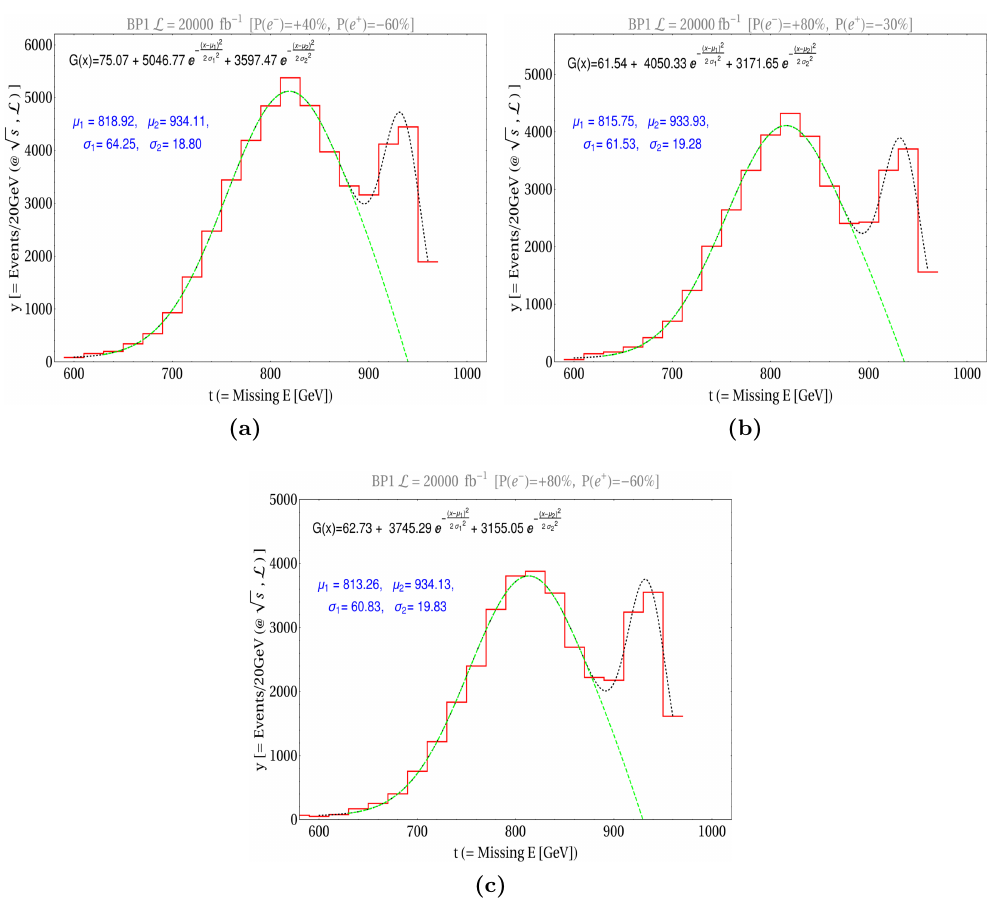
Figure 35. /E distribution for BP1 together with SM background and Gaussian fit for different beam polarizations: (a) P 1 0 ≡ { P : +0 . 4 , P : − 0 . 6 } ; ( b ) P 3 ≡ { P e + e − : +0 . 8 , P : − 0 . 6 } P 3 0 ≡ { P e + e −